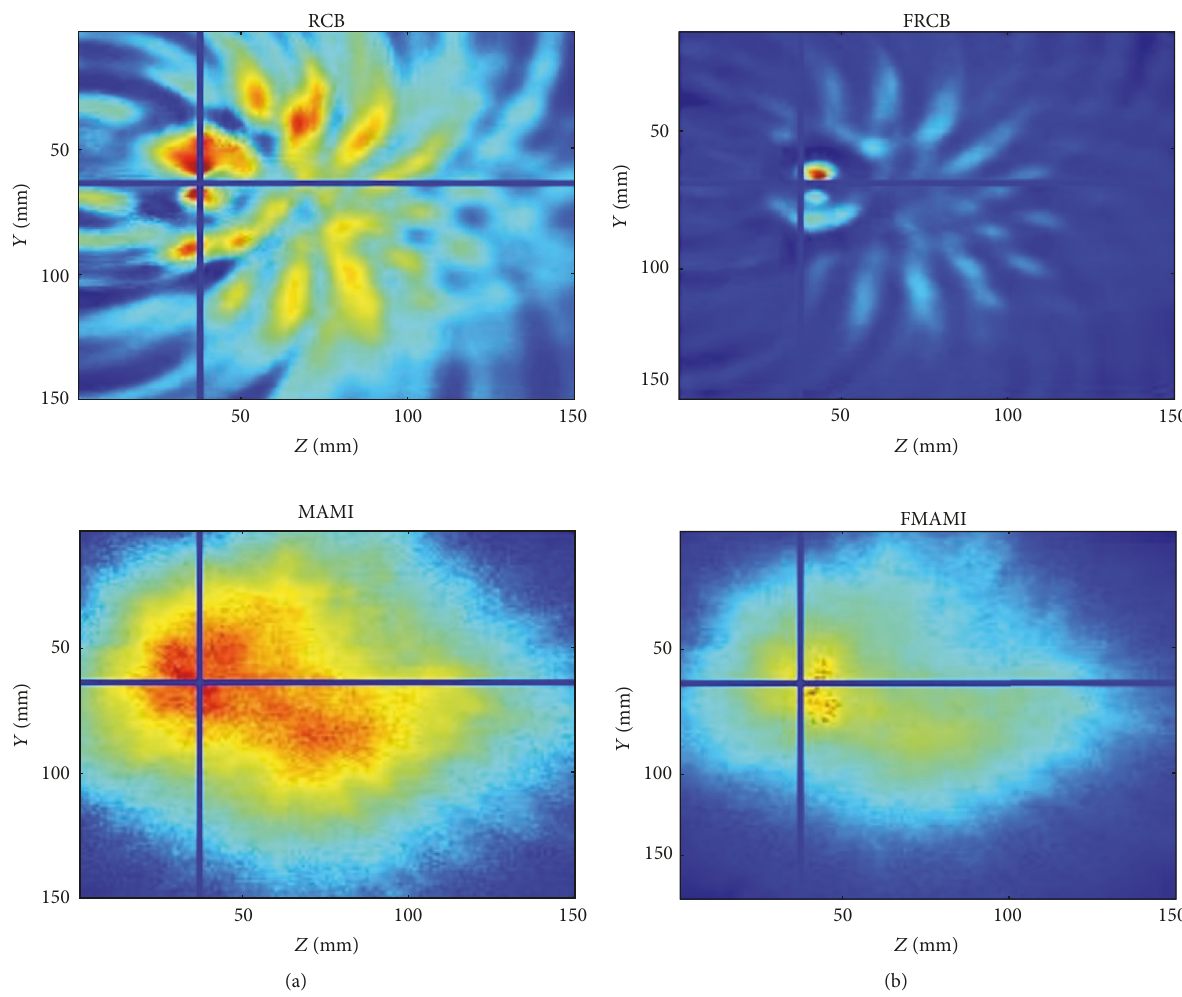
Figure 17: 2D slice of reconstructed images from National University of Ireland Galway (a) without prefiltering and (b) with prefiltering [23]. Reproduced courtesy of The Electromagnetics